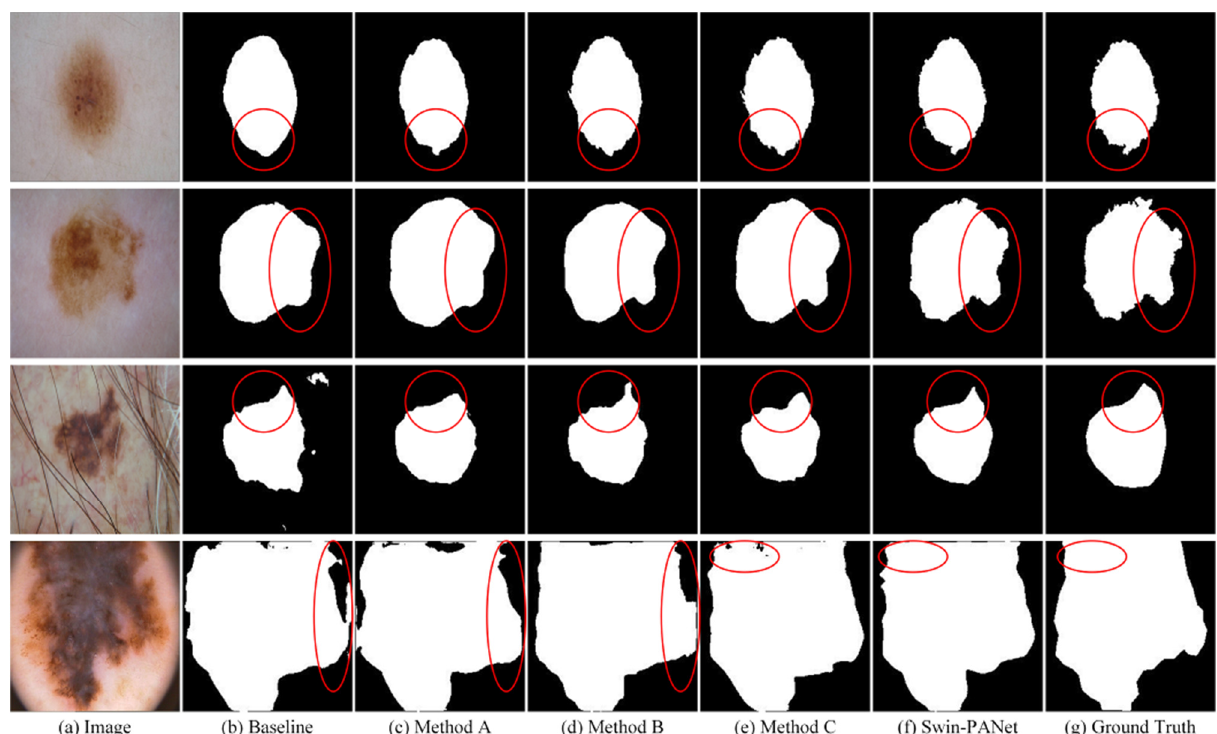
Figure 6. Visual comparisons of skin lesion segmentation results produced by kinds of baselines on ISIC 2016 dataset. The baseline denotes the traditional network of U-Net. The Method A, Method B, and Method C denotes, respectively, the baseline with AGD, Swin-Trans, AGD + EAB. The regions highlighted by red boxes show that Swin-PANet has the capability of modeling global dependencies between boundary pixels and accurately segmenting the ambiguous boundary.